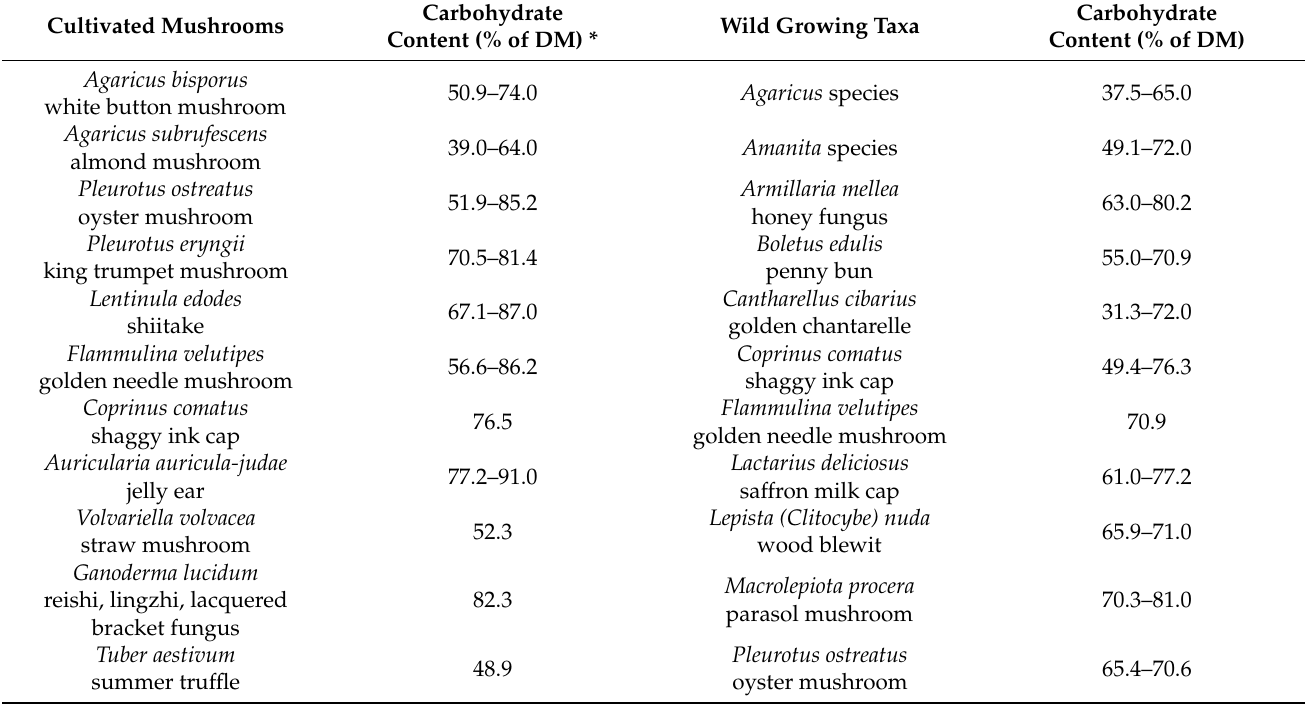
Table 1. Total carbohydrate contents of some cultivated and wild-growing mushroom taxa